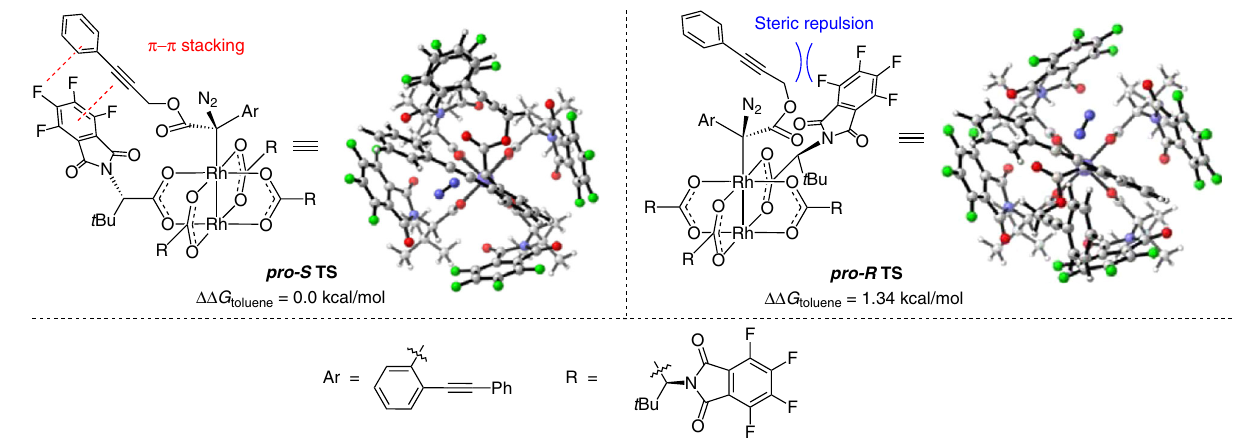
Fig. 4 Enantioselectivity transition states of reaction 2 with substrate 3a. The pro - R TS is 1.34 kcal/mol higher than the corresponding pro - S TS , suggesting that the experimenal ee % value should be up to 80%. Calculations at